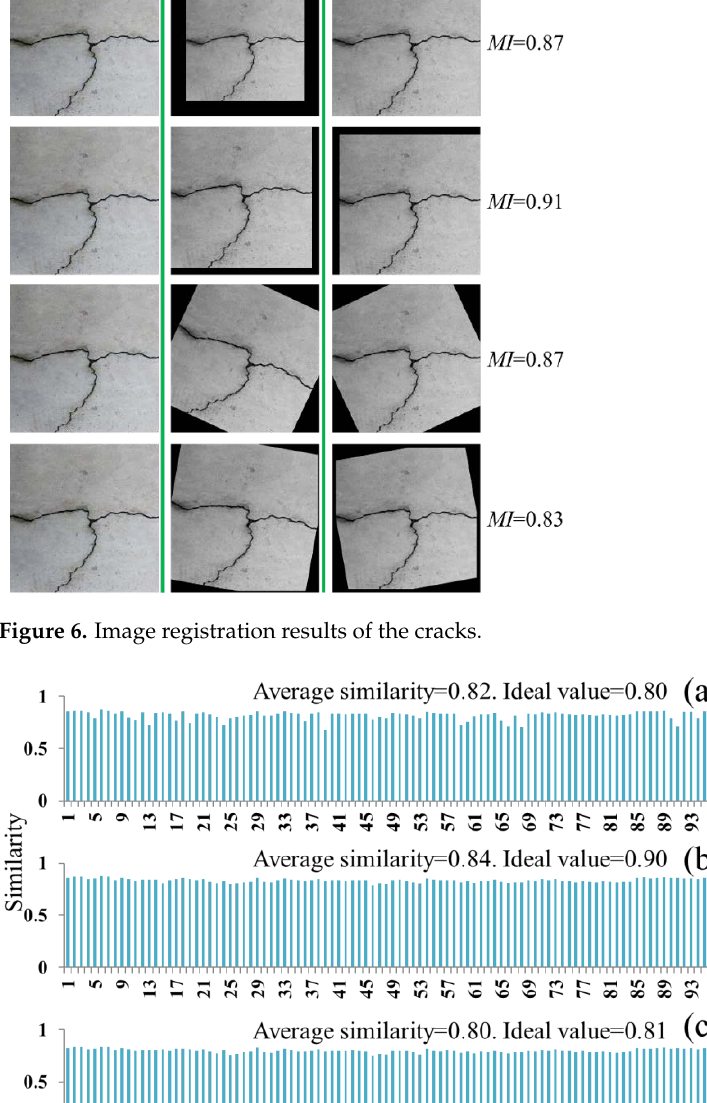
Figure 8. The registration similarity of the translation images. ( a ) [x = − 10, y = − 10]; ( b ) [x = − 30, y = − 30]; and ( c ) [x = − 50, y = − 50].